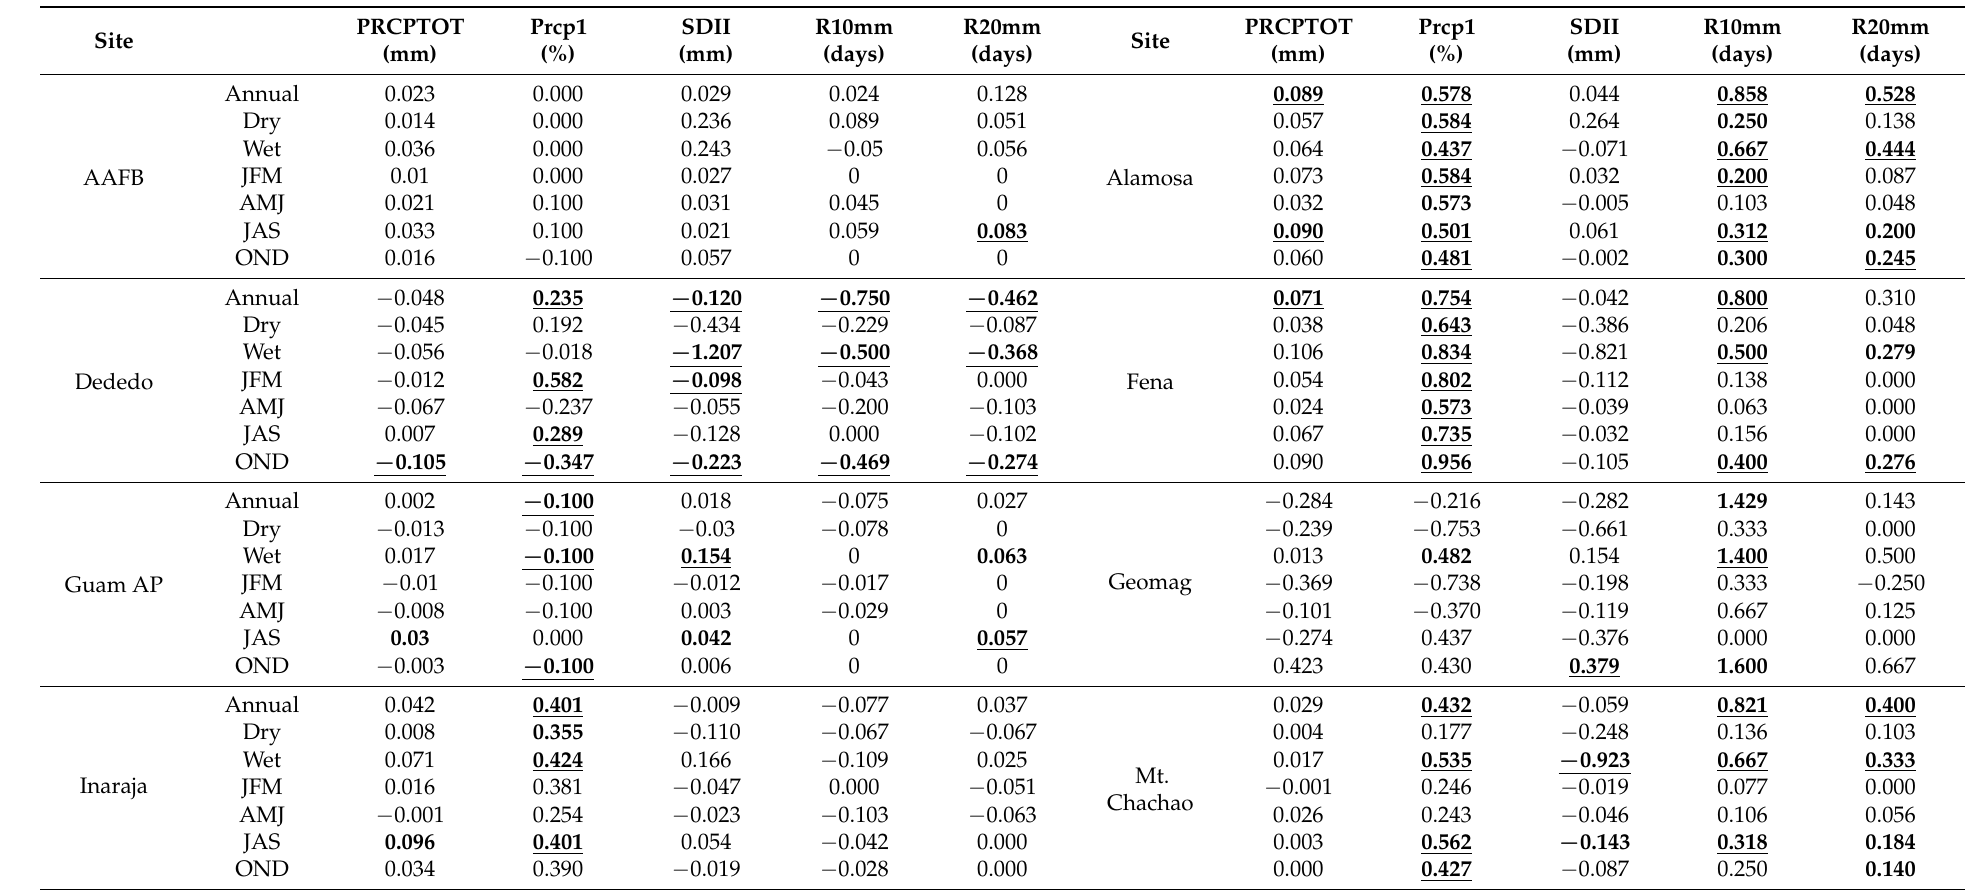
Table 5. Magnitudes (Sen’s slopes) of the increasing or decreasing trends in PRCPTOT, Prcp1, SDII, R10mm, and R20mm. Bold and underlined values represent statistically significant strong trend ( p ≤ 0.05), and those bold represent a significant trend (0.05 < p -value ≤